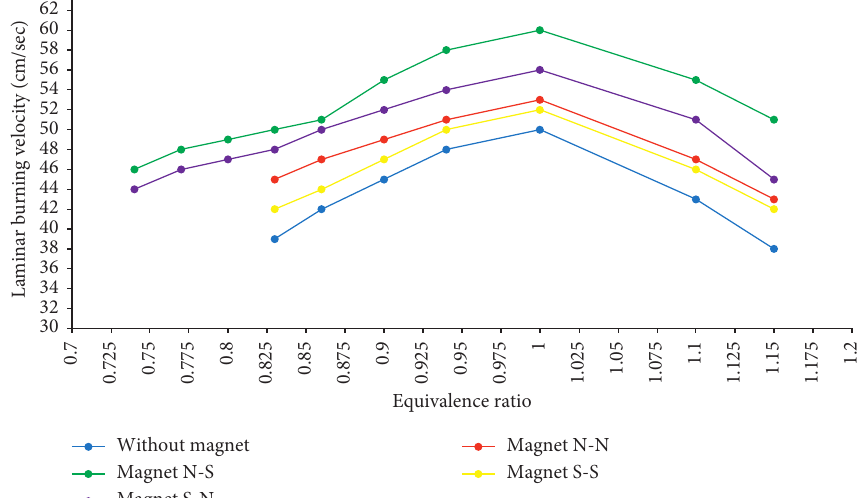
Figure 6: Laminar burning velocity of coconut oil versus equivalence ratio at various magnetic field orientations and without magnetic